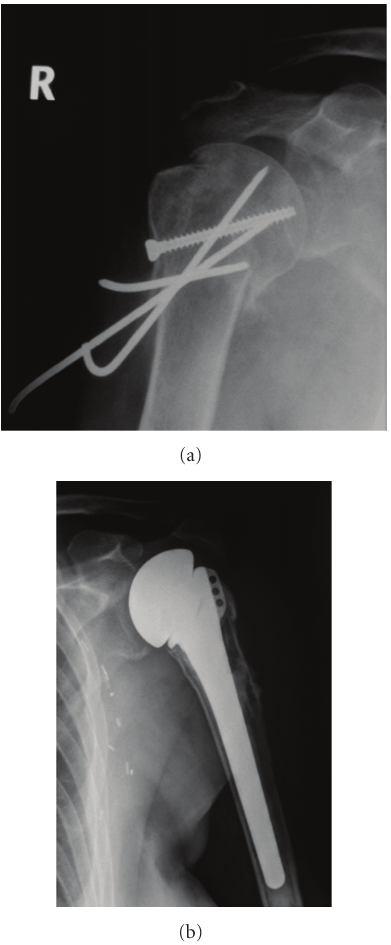
Figure 3: Postoperative radiographs demonstrating internal fix- ation with 2.7mm threaded wires and figure of 8 tension band sutures using number 5 Ethibond suture on the right side and a hemiarthroplasty on the left